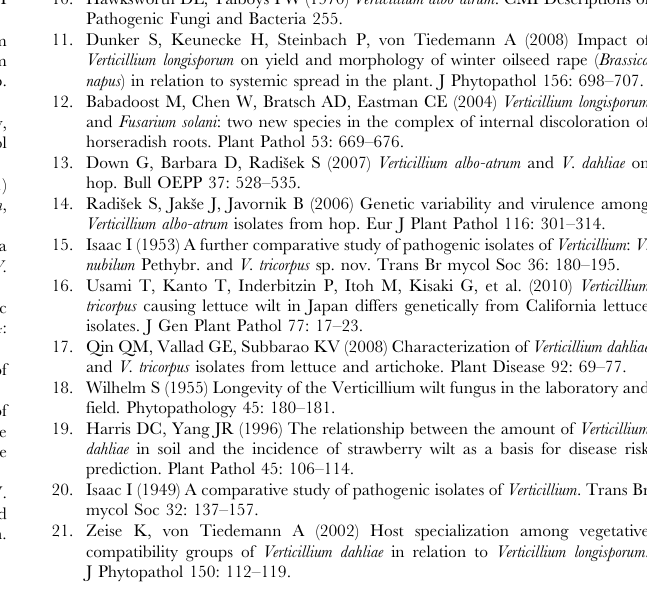
Table S1 Total counts of positive and negative control isolates used in the validation of Verticillium species and V. longisporum lineage specific primer pairs in both simplex and multiplex PCR assays. Table S2 GenBank and other accession numbers of DNA sequences used for primer design. Table S3 Primers designed in this study, primer names reflect deployment in PCR assays: ‘Aa’ = V. albo-atrum ,